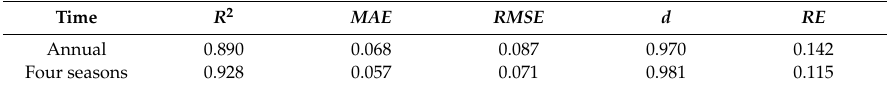
Figure 4. Comparison of estimated daily relative sunshine duration by Equations (13) and (14), and measured daily relative sunshine duration at the 18 meteorological stations for 2016. Table 2. Statistics for the estimation of relative sunshine duration at 18 meteorological stations daily from 1 January to 31 December, 2016 over the Three-River Headwaters region.